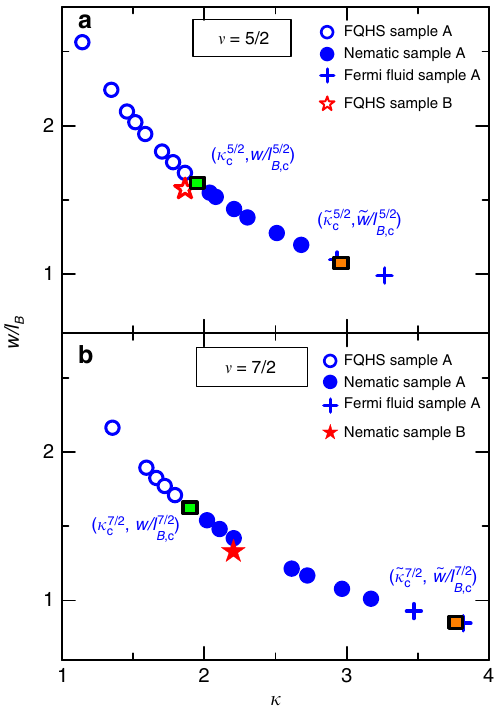
Fig. 5 Sampling of the κ – w / l B space at half- fi lling. Parameters are calculated at ν = 5/2 ( a ) and ν = 7/2 ( b ). Open symbols represent fractional quantum Hall states, closed ones nematics, and crosses Fermi fl uid ground states. Squares are quantum critical points for our pressurized sample A. Stars show parameters for sample B, measured at ambient